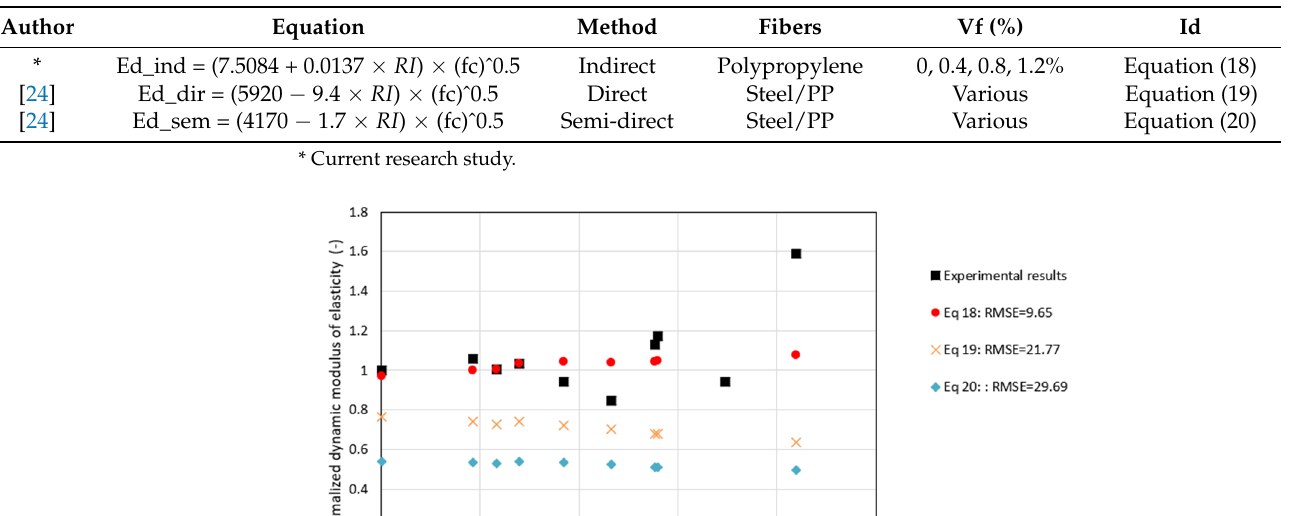
Table 8. Dynamic modulus of elasticity prediction equations based on reinforcement index and compressive strength.